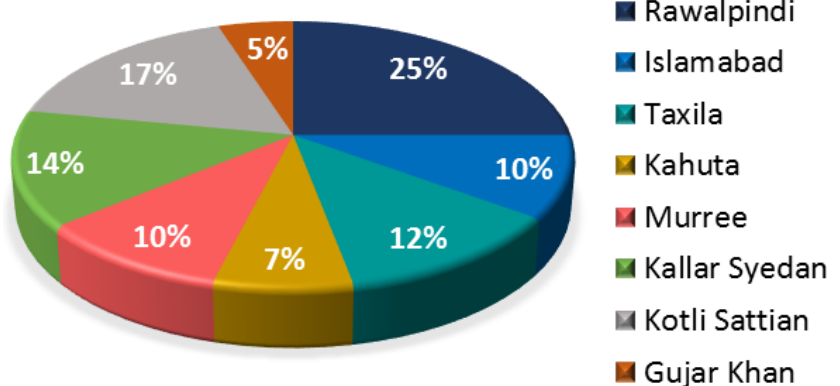
Figure 2. Pie chart showing the distribution of the bovine fecal E. coli isolates according to their isolation locations.